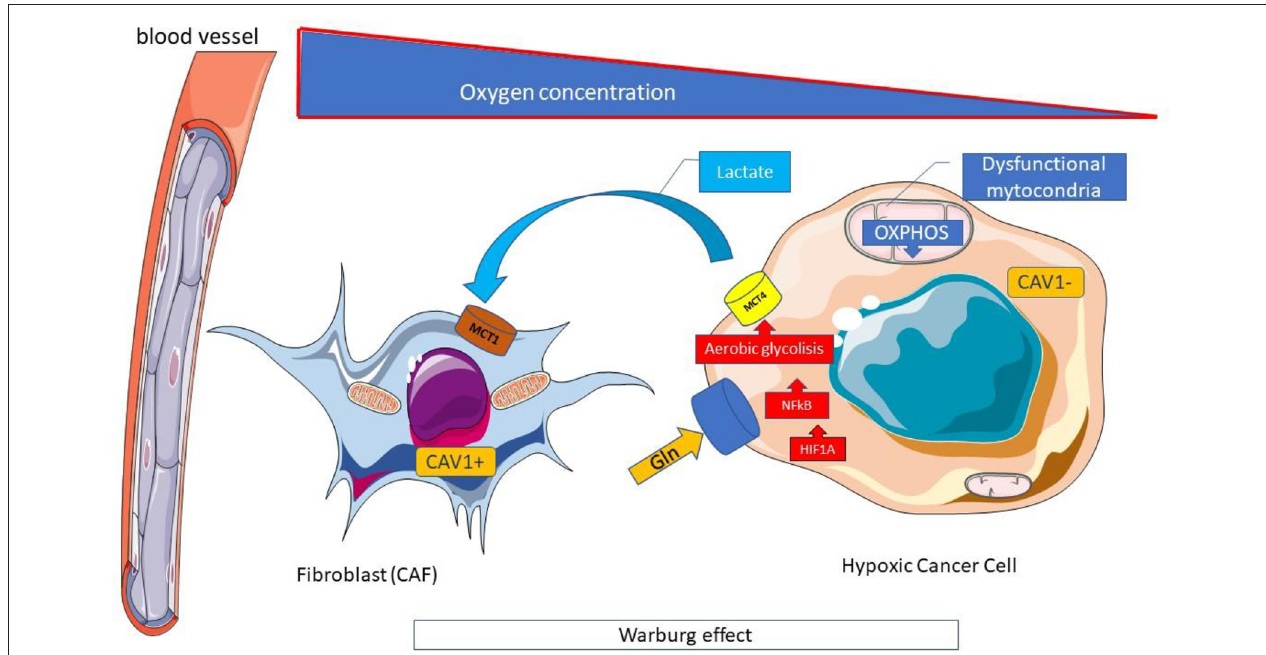
FIGURE 5 | Warburg effect. The Warburg effect is a form of modified cell metabolism observed in many neoplastic cells where, unlike normal differentiated cells, which rely primarily on mitochondrial oxidative phosphorylation to generate the energy needed for cellular processes, relies on aerobic glycolysis. Aerobic glycolysis is an apparently inefficient way of generating adenosine 5’-triphosphate (ATP), compared to oxidative phosphorylation which allows the production of ATP by the oxidative disruption of pyruvate in mitochondria. However, the rate of glucose metabolism through aerobic glycolysis is higher, so that lactate production from glucose takes place 10–100 times faster than complete glucose oxidation in mitochondria. The metabolic difference observed by Warburg adapts cancer cells to hypoxic (oxygen deficient) conditions within solid tumors and derives largely from the same mutations of oncogenes and tumor suppressor genes that cause the other abnormal characteristics of cancer cells. Hypoxic conditions could induce HIF1A, a major regulator of glucose metabolism, and activate the expression of key enzymes for glycolysis. The high use of glucose in aerobic glycolysis, in addition to the high production of ATP, and the increase in the pathway of pentose phosphates, both essential for the anabolic processes necessary to support cell proliferation, is associated with the production of high levels of lactate and the acidification of the tumor microenvironment which plays a favorable role to the growth of neoplastic. CAV, Caveolin; Gln, Glutamine; MCT, Monocarboxylated transporter; OXPHOS, Oxidative phosphorylation.